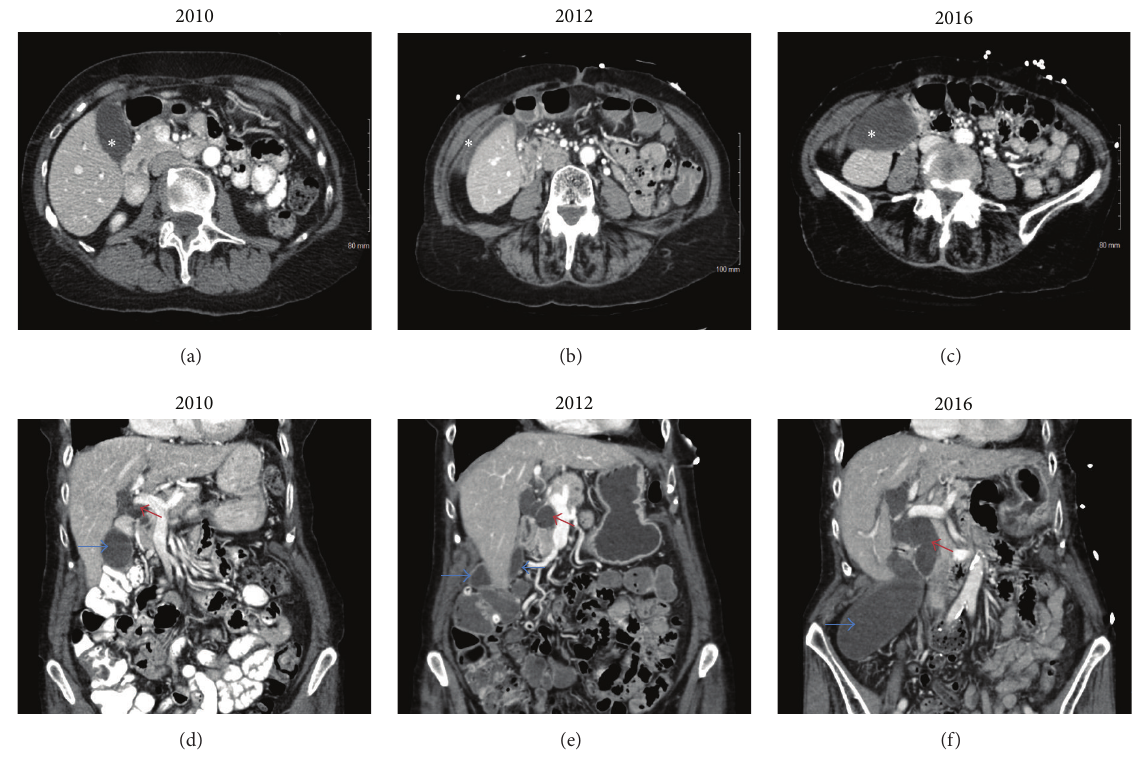
Figure 1: (a), (b), and (c) show computed tomography axial images of the abdomen with the gallbladder marked by ( ∗ ). Notice the different anatomical positions of the gallbladder over a six-year period. (d), (e), and (f) show computed tomography coronal images of the abdomen showing changes in the anatomical position of the gallbladder (blue arrow); the choledochal cyst (red arrow) is shown to be increasing in size over the same